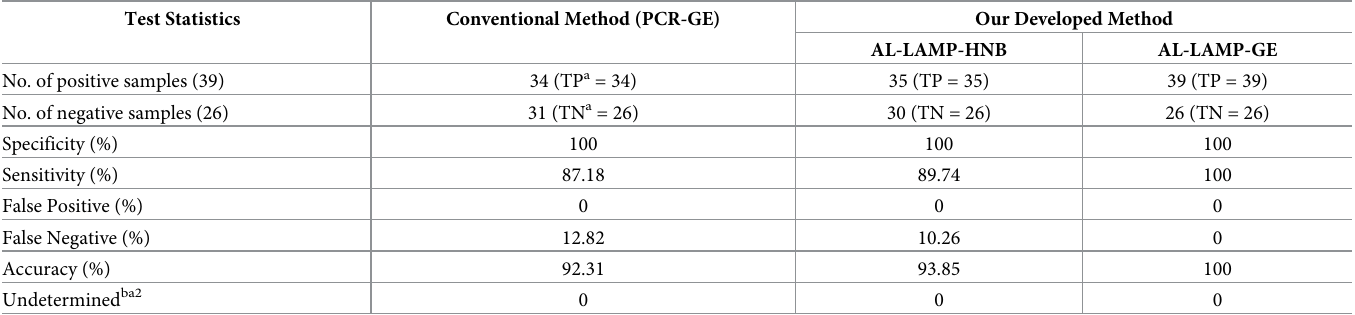
Table 2. Comparison of our developed assay (AL-LAMP-HNB and AL-LAMP-GE) to molecular conventional methods (commercial DNA extraction kit and PCR-GE) on 65 orange leaf samples (39 C . Liberibacter asiaticus-infected and 26 mock-infected